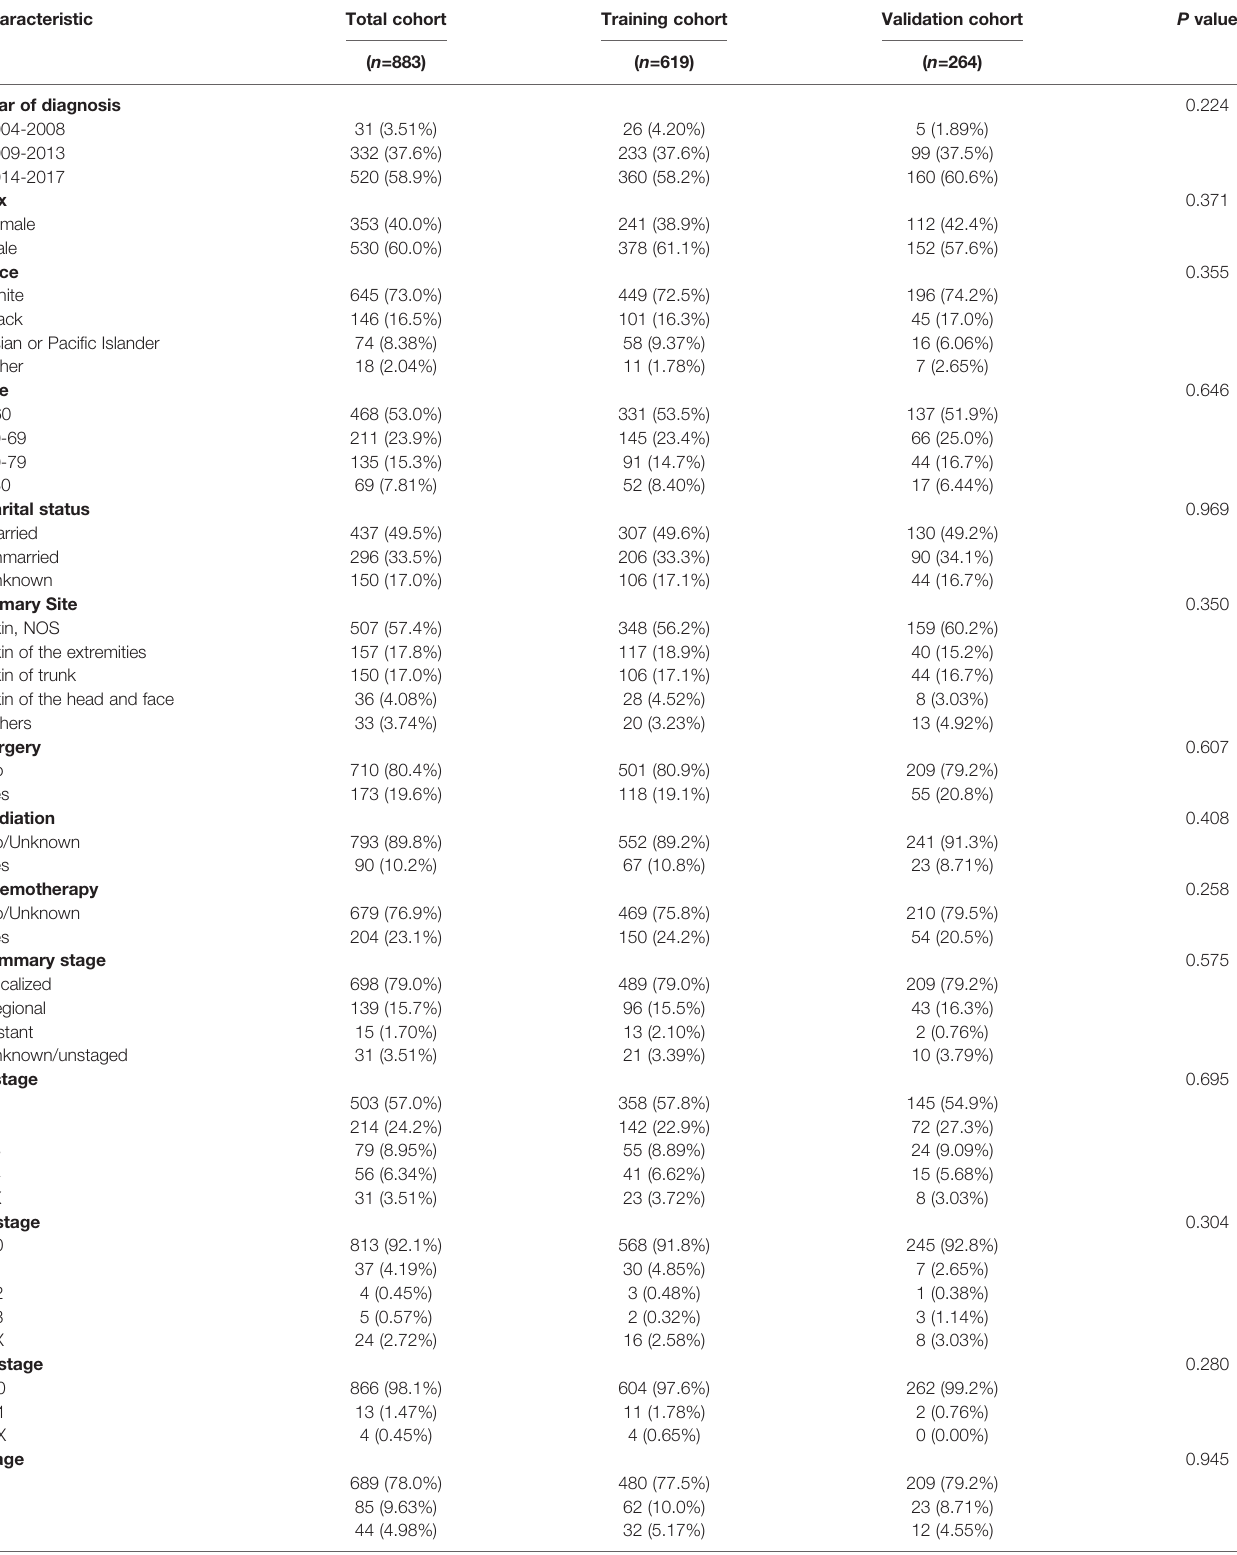
TABLE 1 | Demographic and clinical characteristics of patients with HIV-associated CTCL.